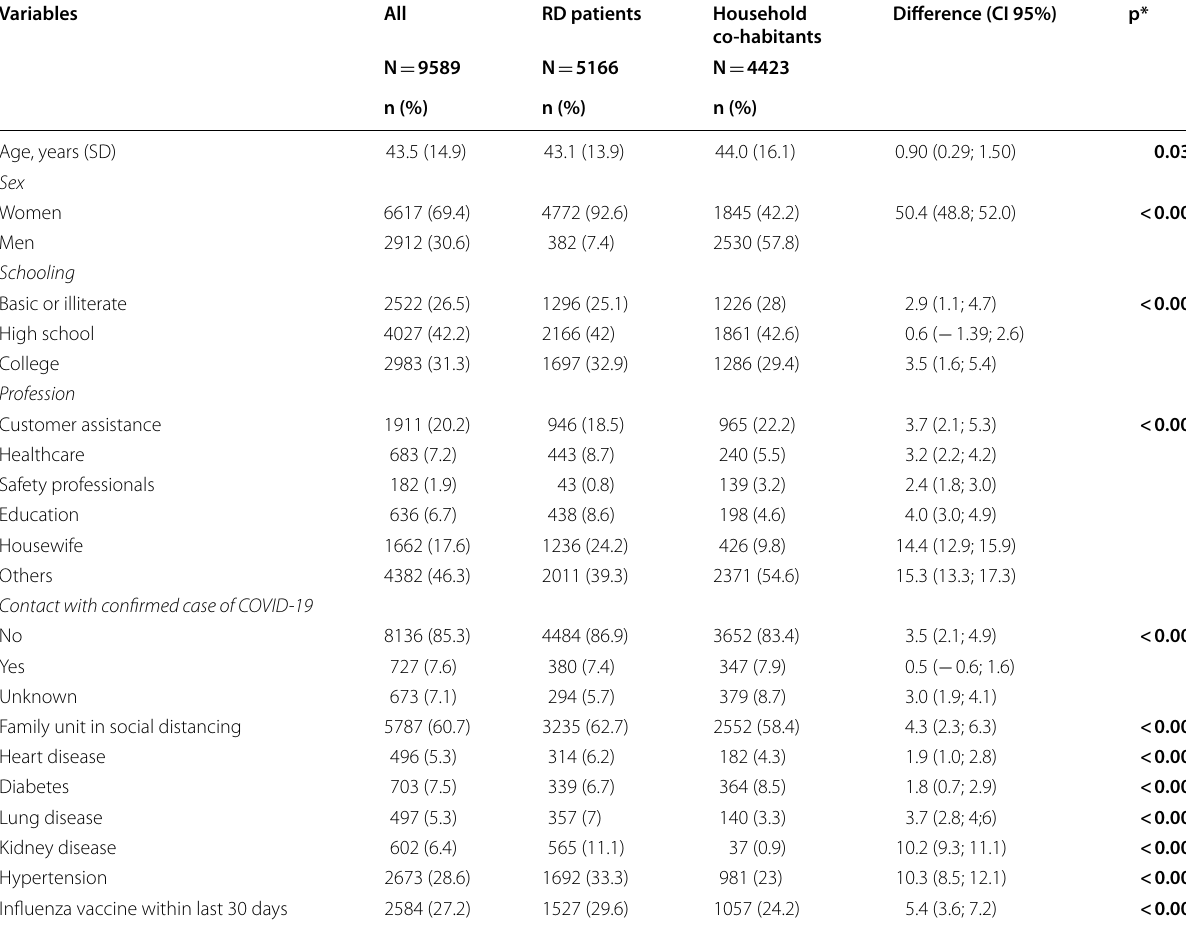
Bold values indicate statistical significance (p < 0.05) The results are expressed as means, standard deviation and percentages CI, confidence interval; RD, rheumatic diseases; COVID-19, Coronavirus disease 2019 * Chi-square